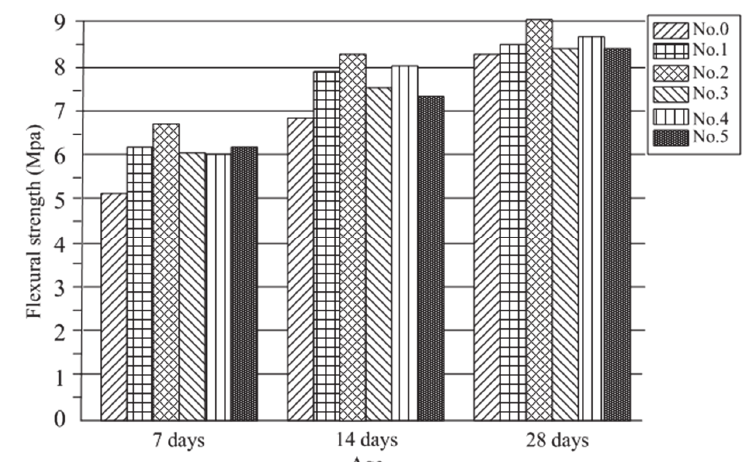
Figure 6: The variation of the bending strength of carbon nano-tubes cement-based composite materials test specimens along with the change of age.